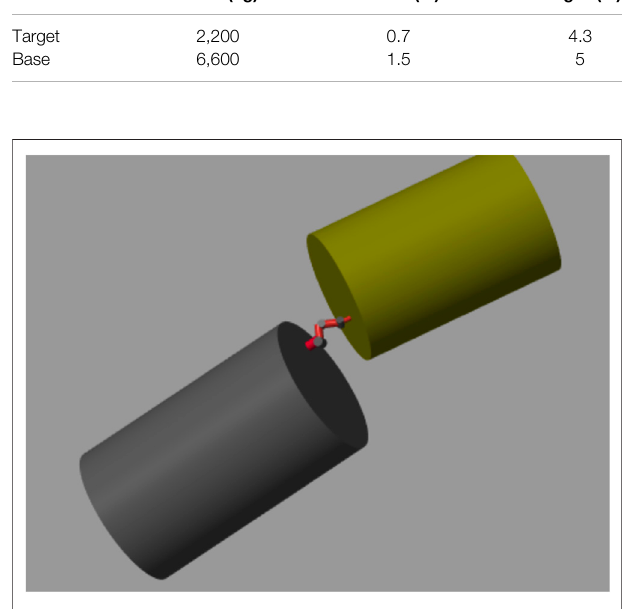
FIGURE 3 | Simulation model of Baxter arm with target satellite (gold) and base satellite